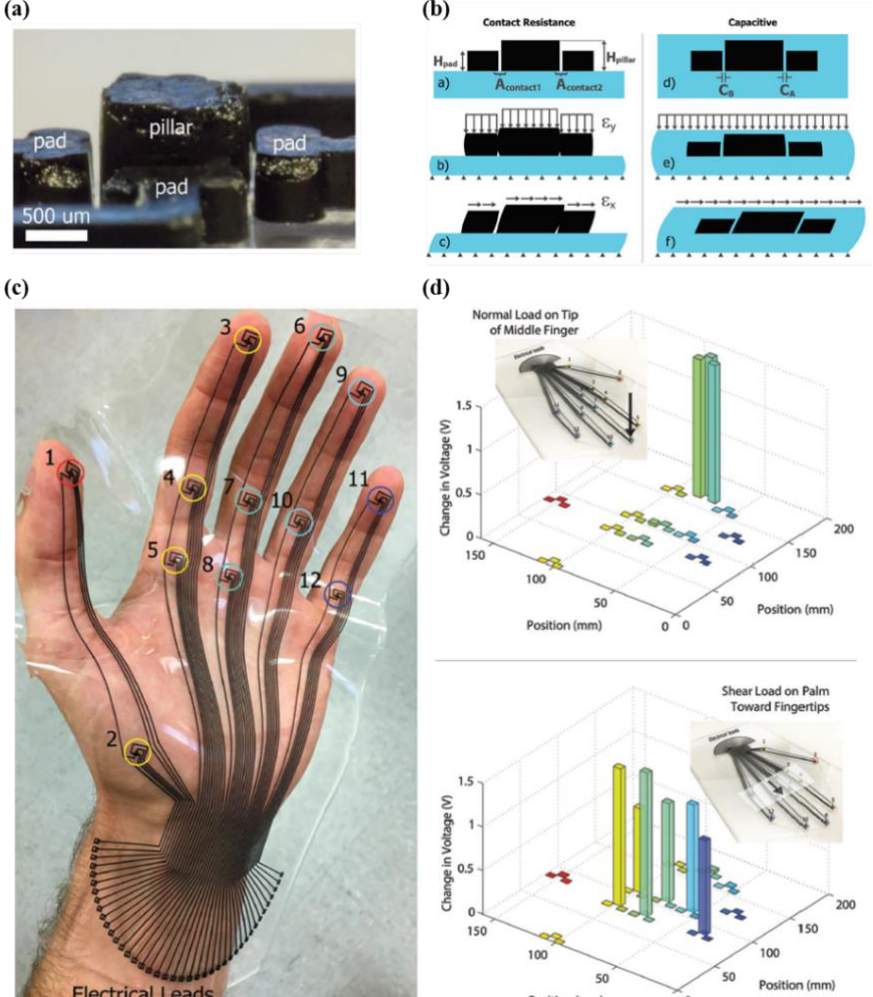
Figure 8. ( a ) Magnified image showing the structure of a unit cell; ( b ) schematic illustration showing the working mechanism; ( c ) photograph of e-skin that fully covers the area of a human hand; ( d ) changes in voltage under normal and shear loads (reprinted with permission for Figure 8a–d from Ref. [71] Copyright 2016 John Wiley and Sons).